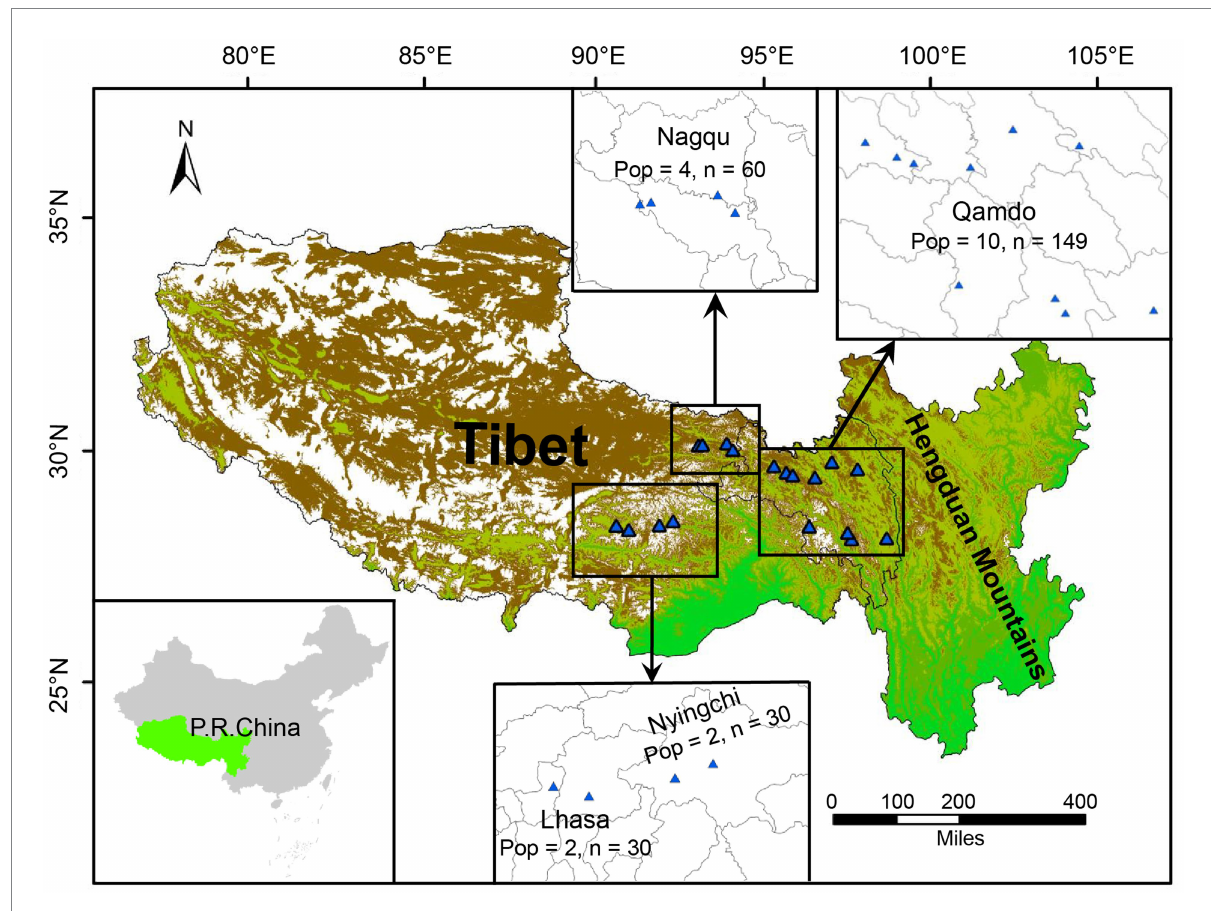
FIGURE 1 Geographical distribution of the Elymus breviaristatus populations in this